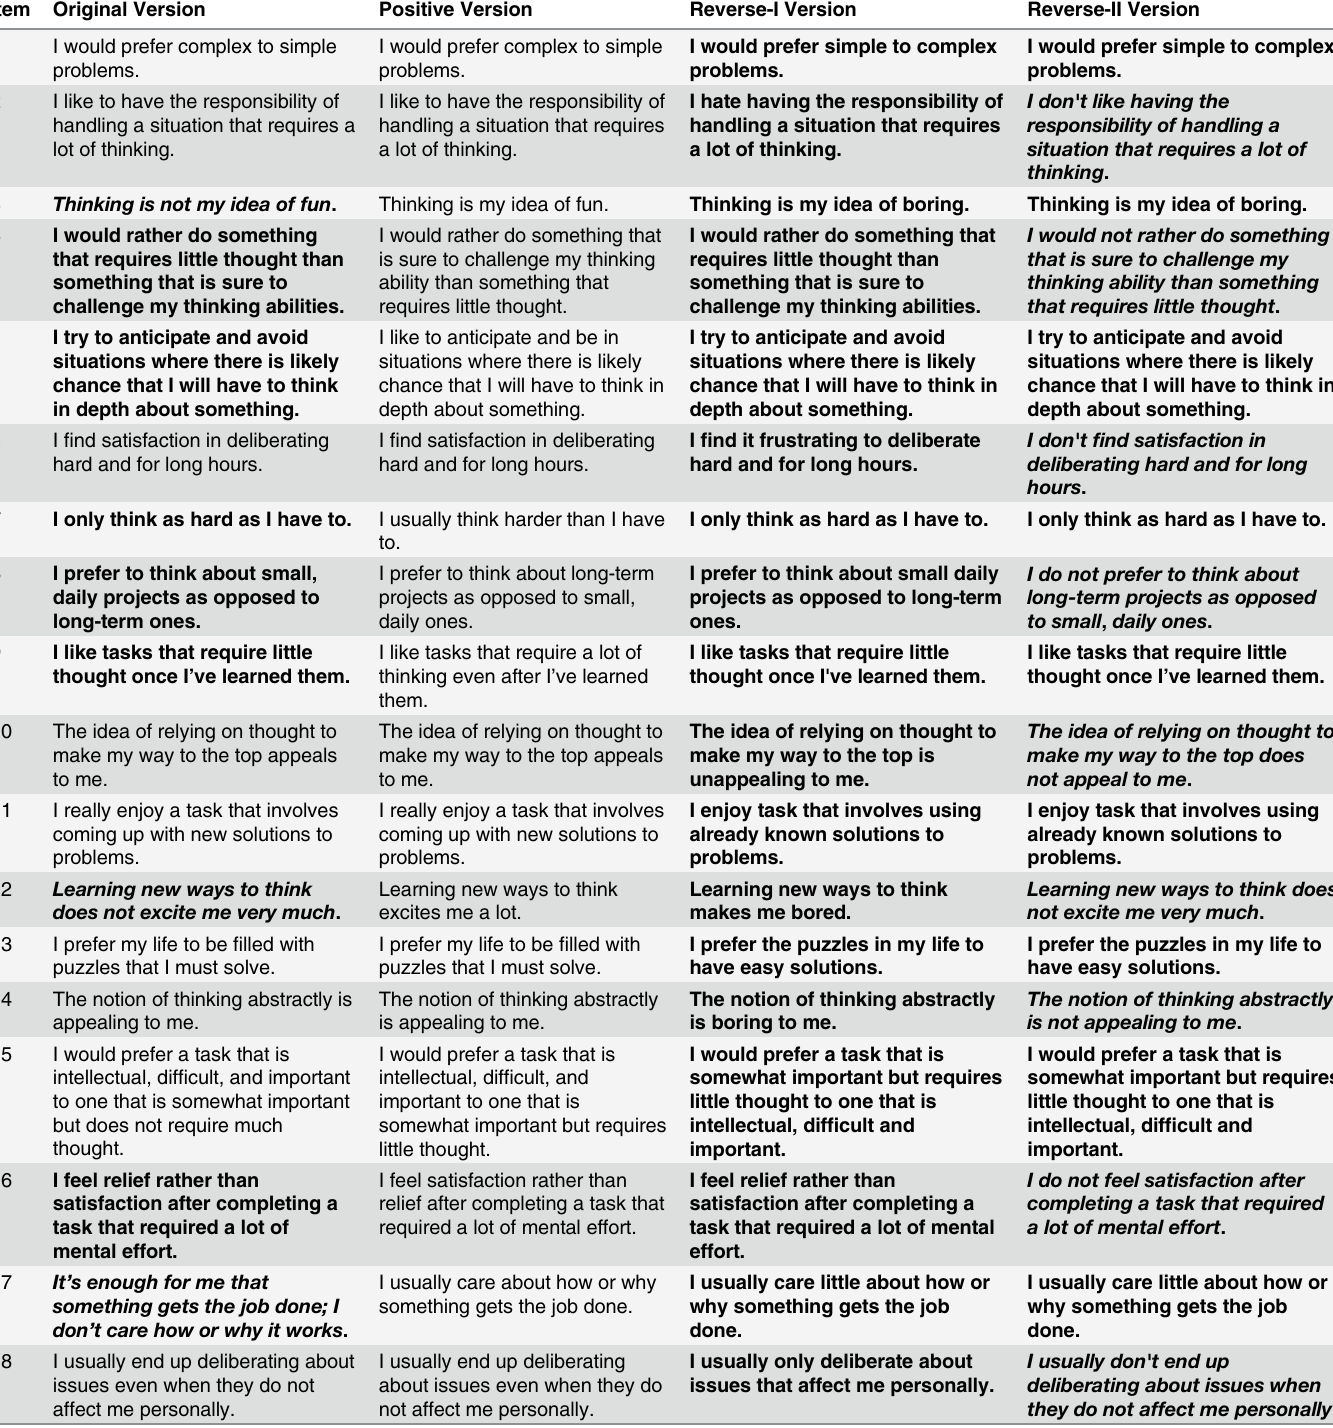
Table 1. Item wording for the four different versions of the abbreviated Need for Cognition (NFC) scale used in the